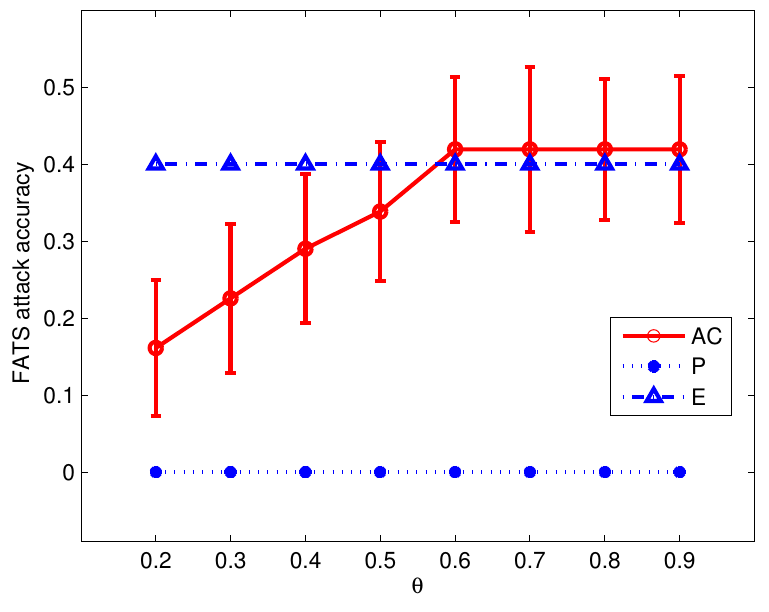
Figure 10. Activity cloak (AC) method privacy level